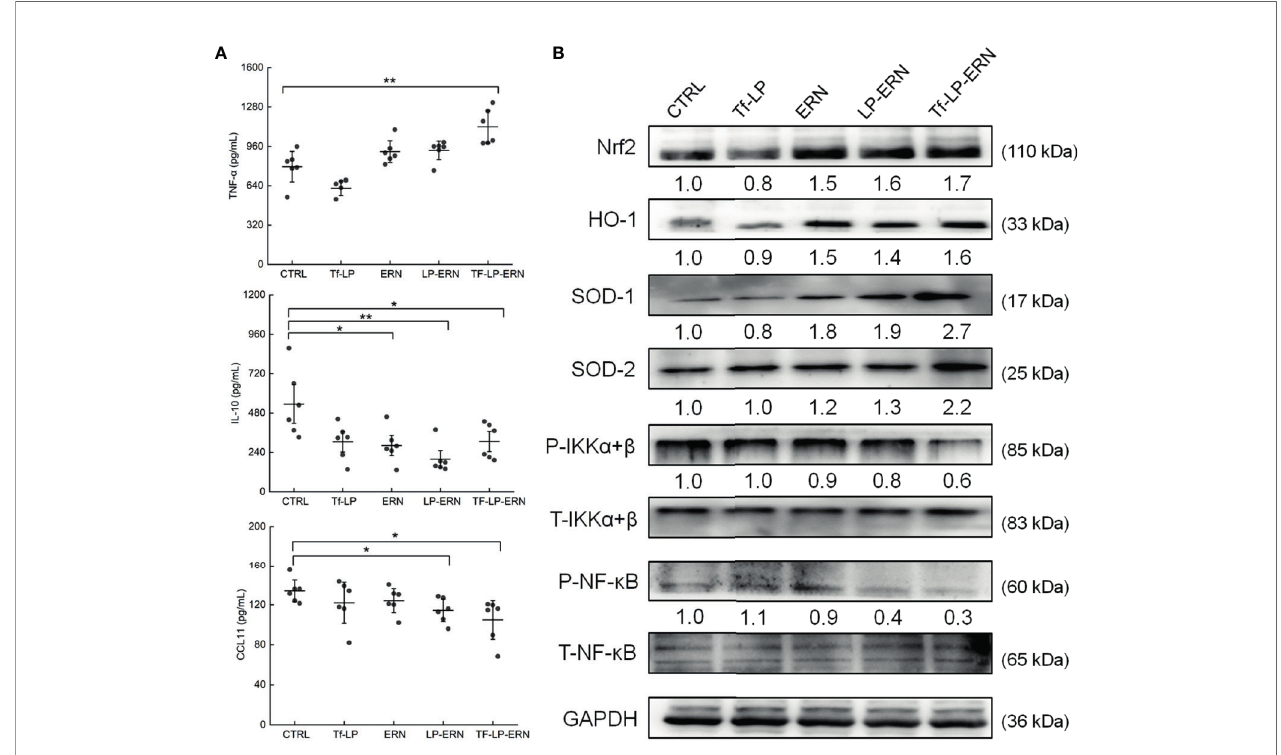
FIGURE 6 | The effects of ERN, LP-ERN and Tf-LP-ERN on in fl ammatory factor in serum of SMMC-7721-tumor-bearing mice. (A) ERN, LP-ERN and Tf-LP-ERN signi fi cantly reduced the levels of IL-10, CCL11, and enhanced the level of TNF- a (n = 6). (B) In spleens of SMMC-7721-xenografted mice, ERN, LP-ERN and Tf-LP- ERN increased the expression levels of Nrf2 and its downstream proteins HO-1, SOD-1, SOD-2, while reduced the expression levels of P-IKK a + b , and P-NF- k B, among which, Tf-LP-ERN showed the best ef fi cacy. Quanti fi cation data were normalized by GAPDH or the corresponding total proteins and were reported as the folds of those from the corresponding CTRL mice (n = 3). The data were analyzed using a one-way analysis of variance and expressed as means ± S.D. (n = 3). * P < 0.05 and ** P < 0.01 vs . control